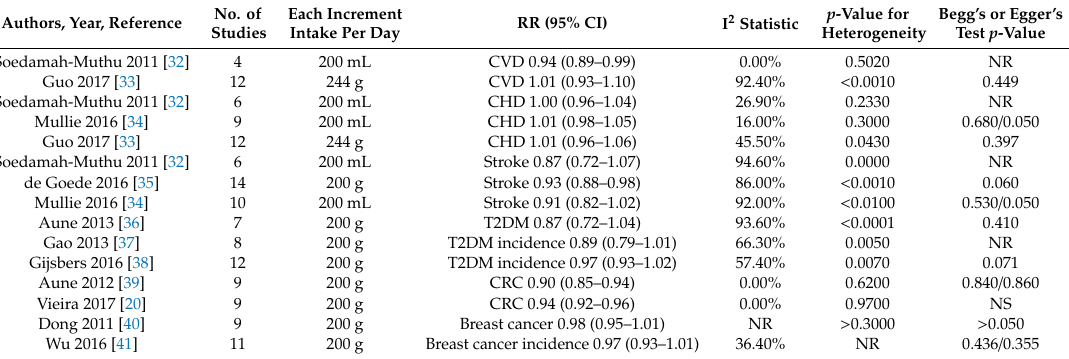
Table 4. Summary of linear dose-response meta-analyses of prospective studies on milk intake and CVD, CHD, stroke, T2DM, CRC, and breast